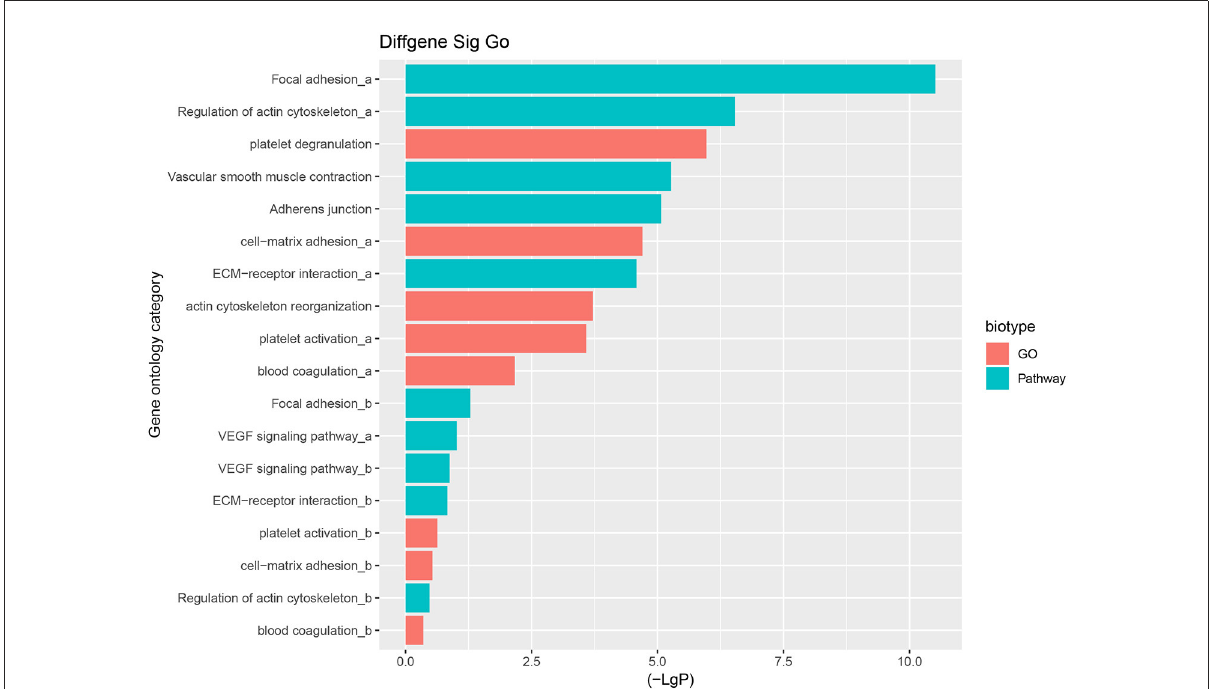
FIGURE7 Selected GO terms and Pathways which are involved in coagulation dysfunction, or abnormalities in vascular structure and function based on GO and KEGG pathway analysis (a represents up-regulated GO terms or Pathways, b represents down-regulated GO terms or Pathways).